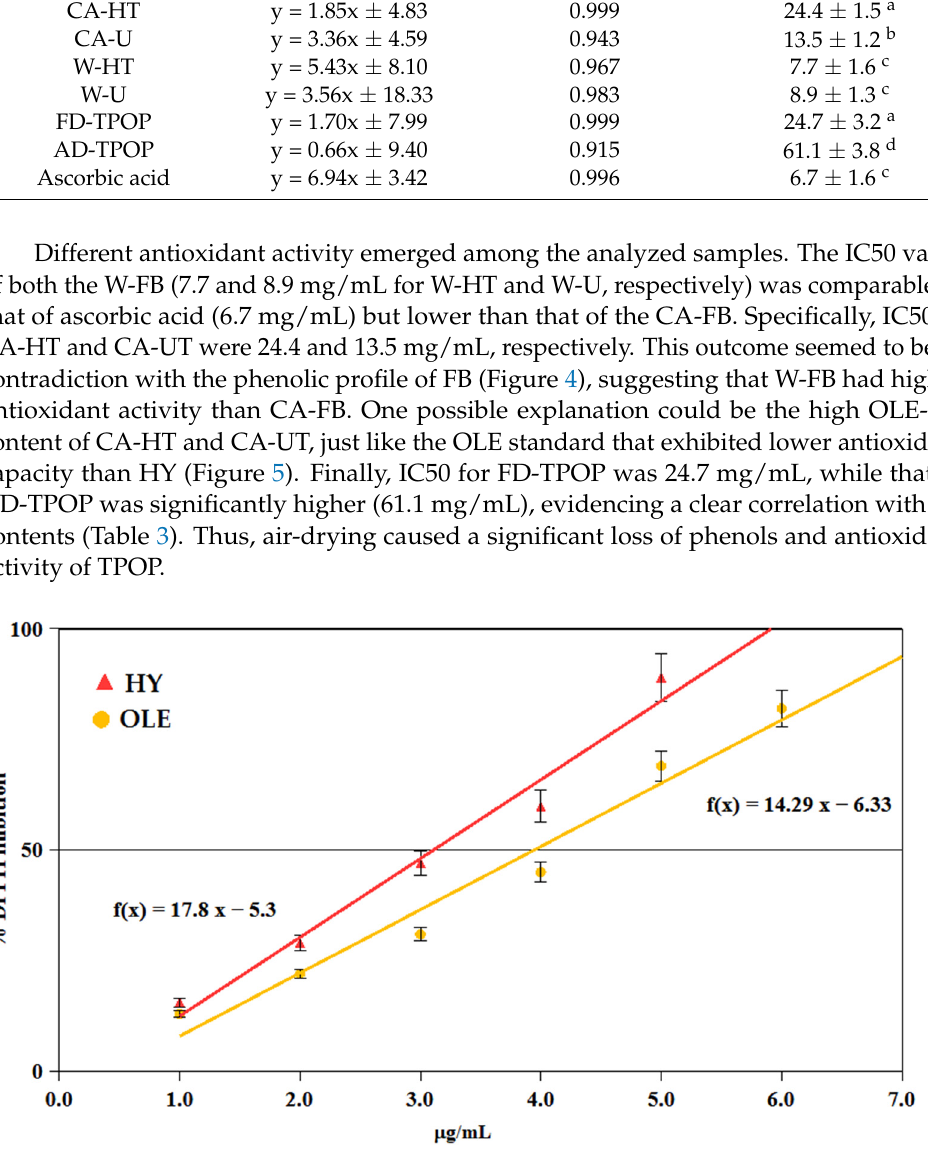
Figure 5. Linear correlation between percentage DPPH free-radical inhibition and concentration (mg/mL) of hydroxytyrosol (HY) and oleuropein (OLE) standards.